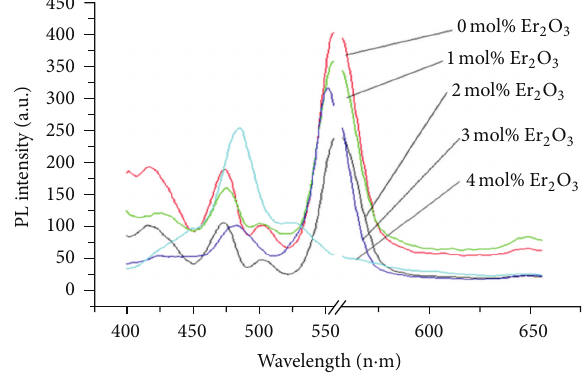
Figure 6: A luminescence spectrum of EZT